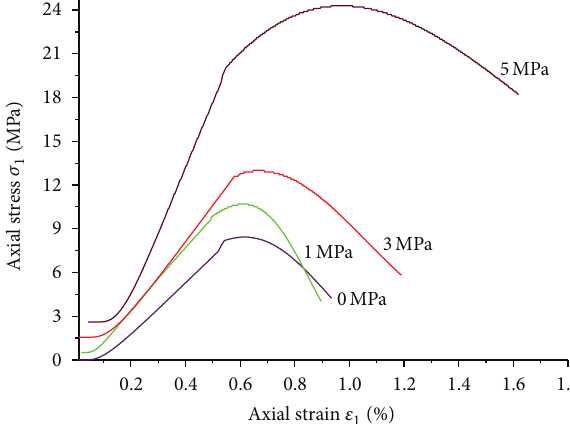
Figure 14: Fitting results of mudstone sample when 𝛽 = 0.9